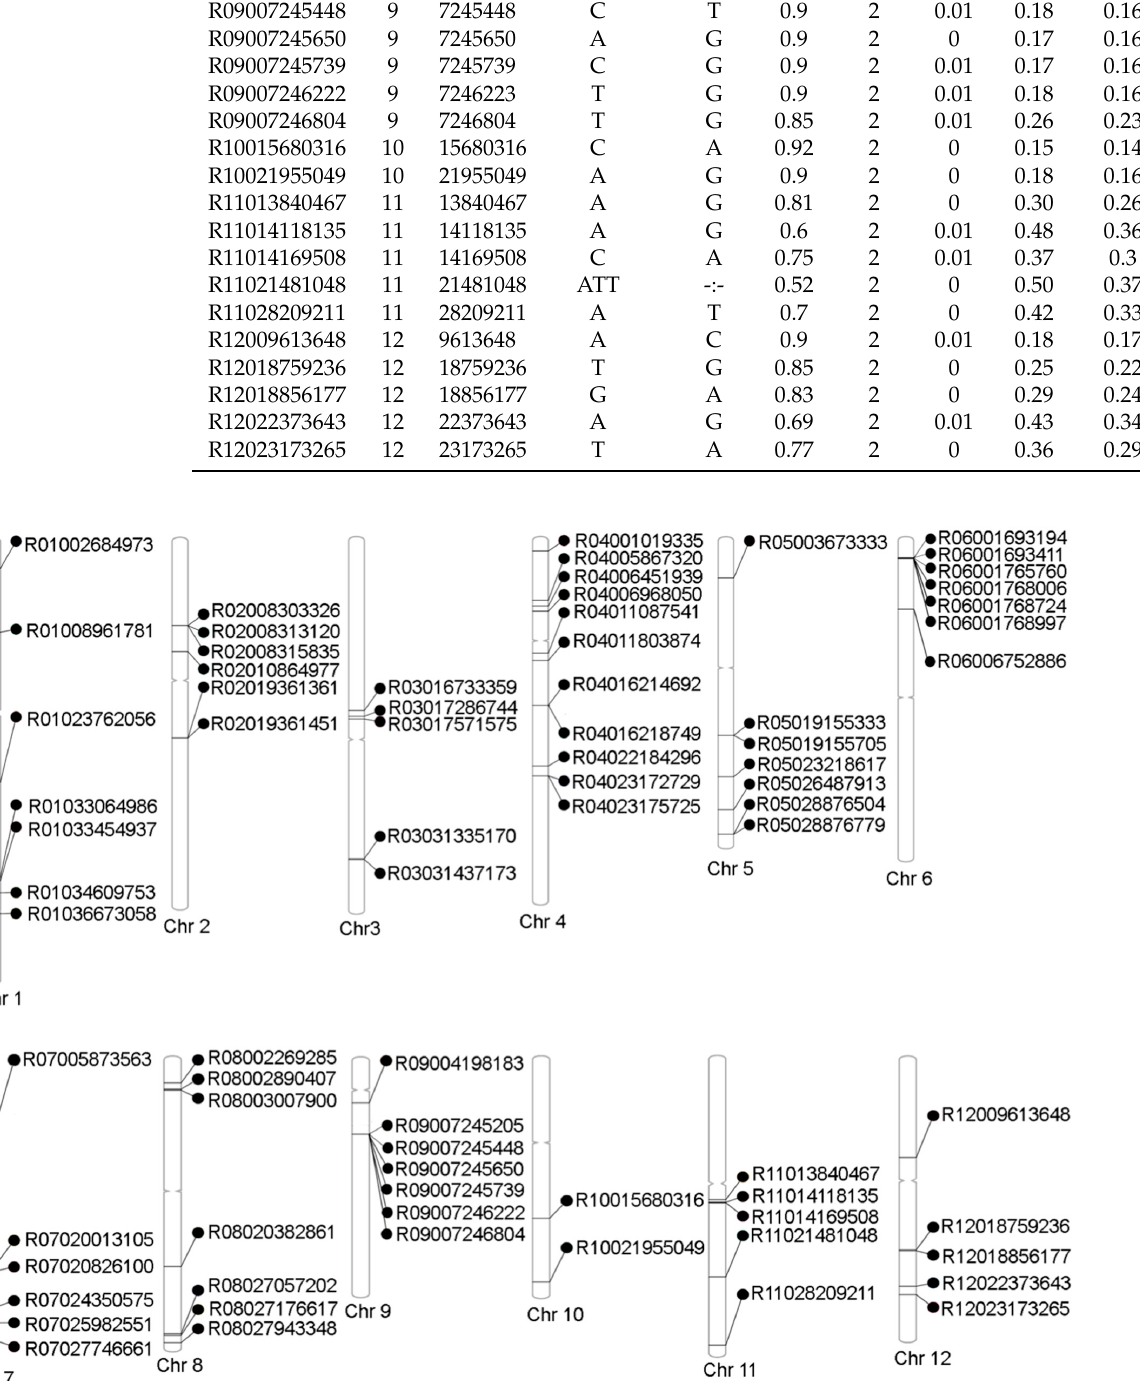
Figure 2. Distribution of the SNP markers used in this study across the 12 rice